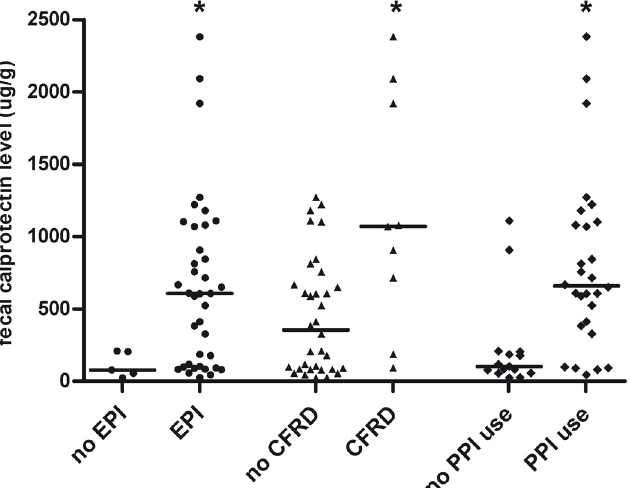
Fig 4. Faecal calprotectin levels were significantly elevated in cystic fibrosis (CF) patients suffering from exocrine pancreatic insufficiency (EPI) or cystic fibrosis-related diabetes (CFRD), and in CF patients using proton pump inhibitors (PPI), as compared with CF patients without these